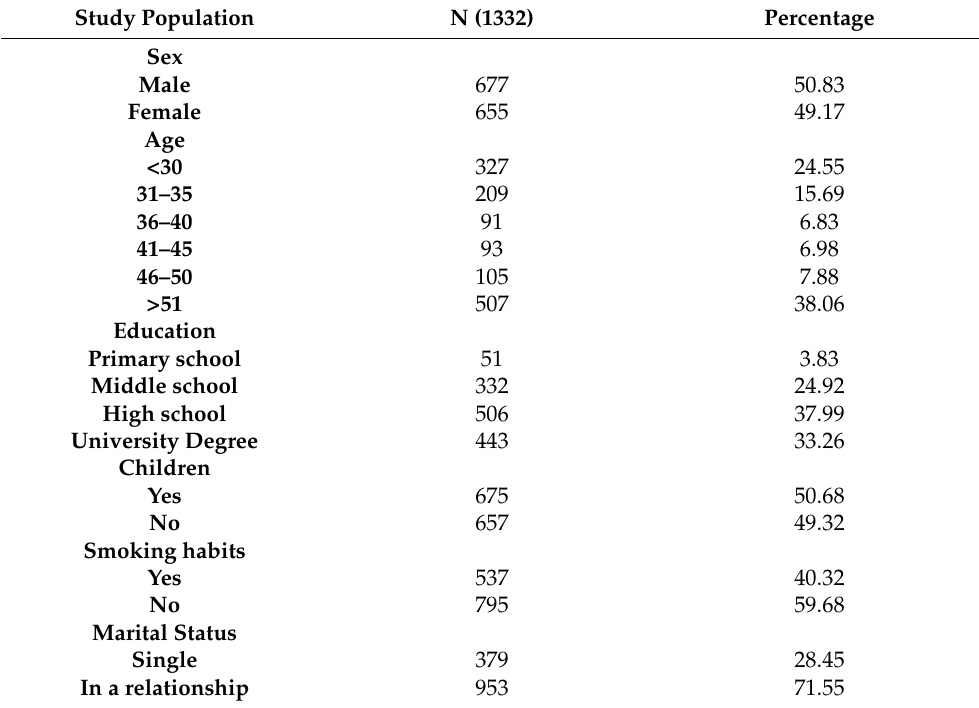
Table 1. Study population